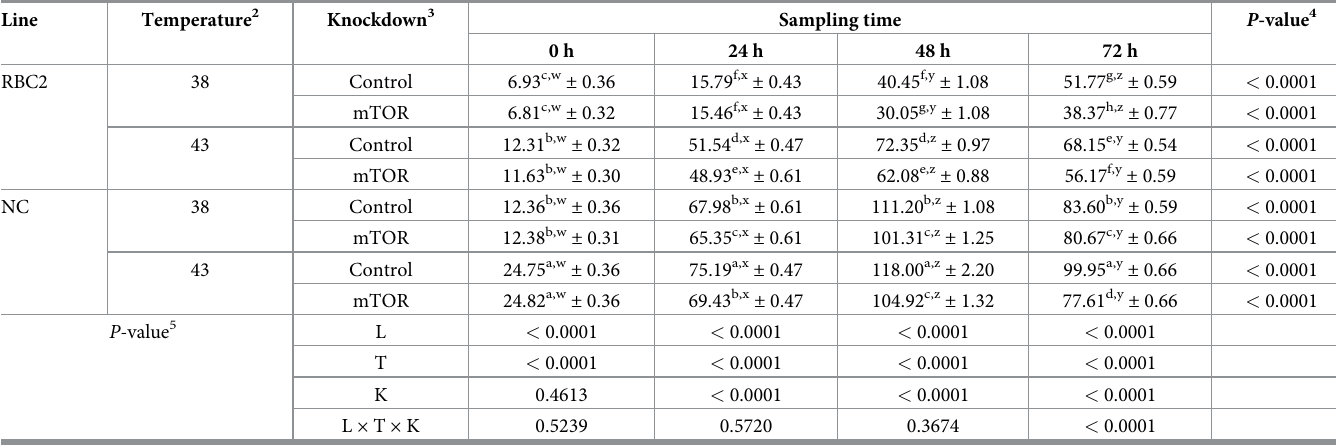
Table 5. Effect of heat stress (43˚C) and knockdown of mTOR at the beginning of differentiation on differentiation of RBC2 and NC line SCs 1 .